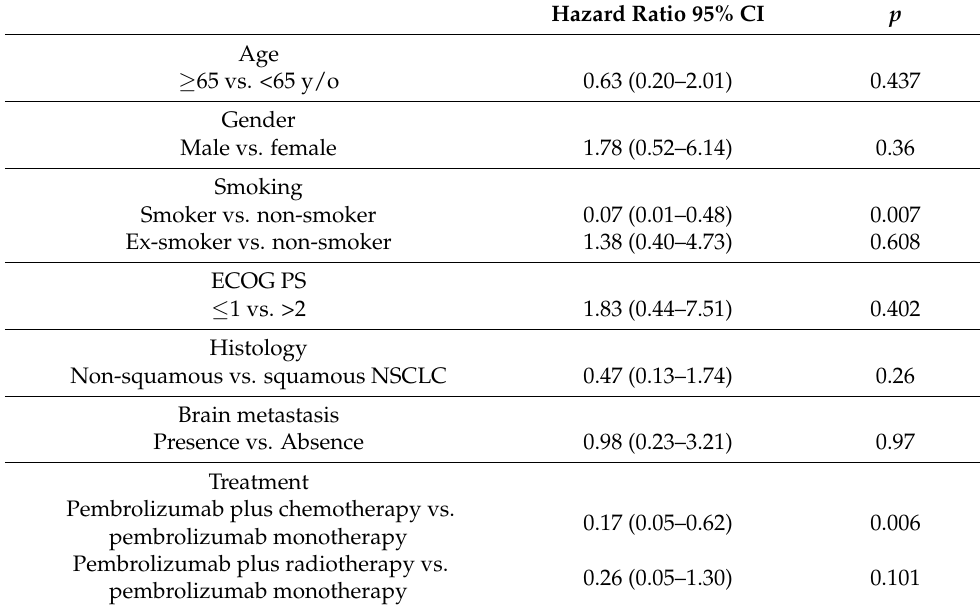
Figure 2. The ( A ) progression-free survival and ( B ) overall survival in patients who received combi- nation therapy or pembrolizumab monotherapy. NR—not reached. Table 2. Cox proportional hazard regression analysis of